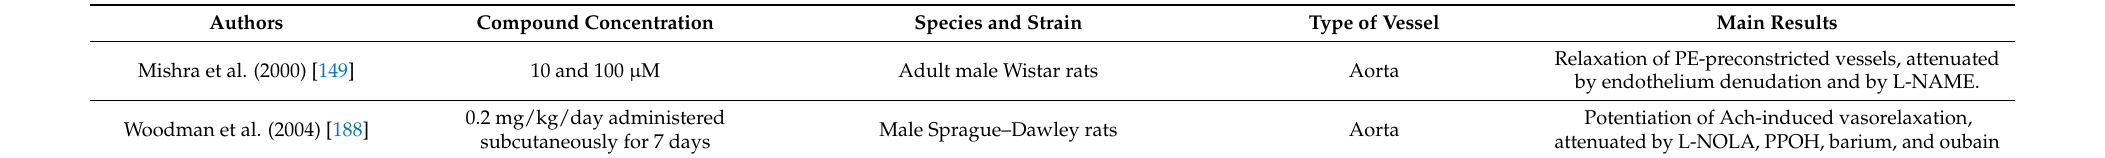
Table 3. Description and main results of in vitro studies on the vasorelaxant activity of